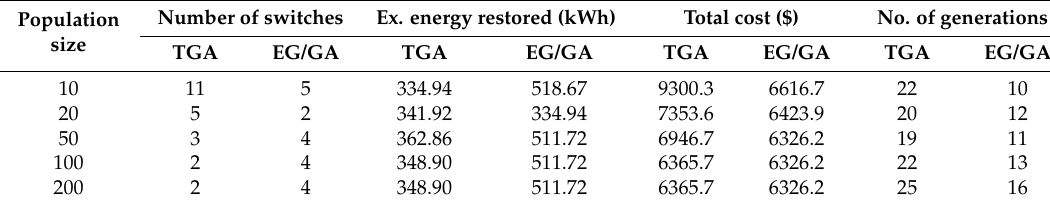
Table 6. Comparison of TGA and EG for Feeder